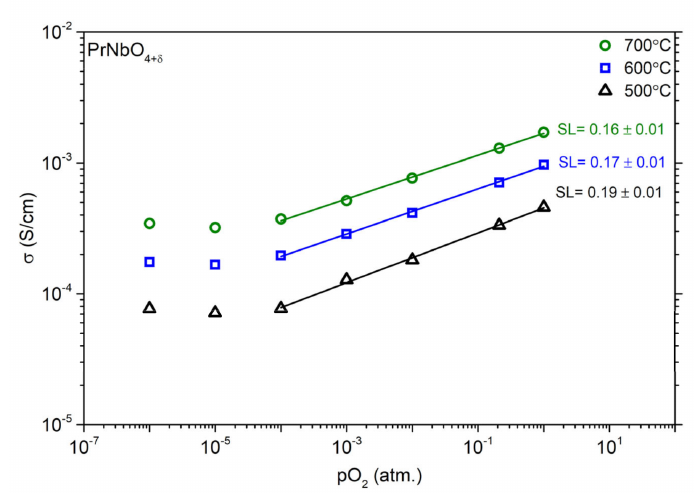
Figure 11. Total conductivity of PrNbO 4+ δ as a function of oxygen partial pressure in dry gases (pH 2 O = 6.0 × 10 − 5 atm) at 500 ◦ C, 600 ◦ C and 700 ◦ C. The SL denotes the slope coefficient of the log ( σ ) as a function of log (pO 2 ).